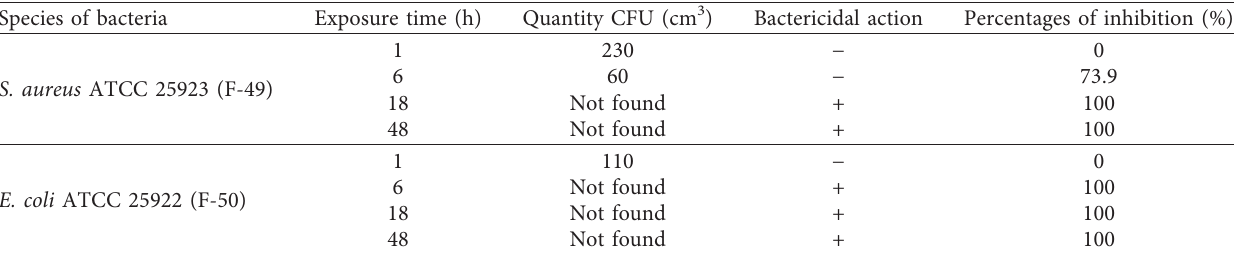
Table 2: Antibacterial properties of colloidal solutions of silver nanoparticles synthesized by the sonoelectrochemical method and stabilized with rhamnolipid solution.